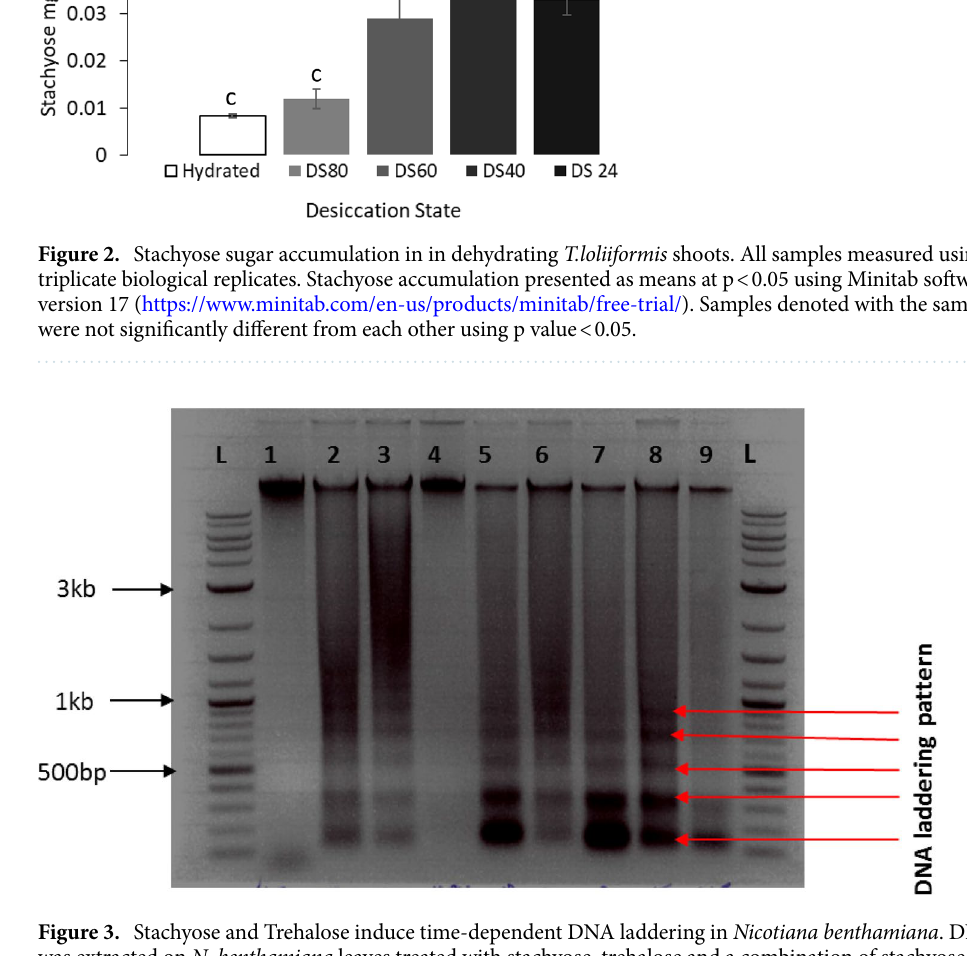
Figure 3. Stachyose and Trehalose induce time-dependent DNA laddering in Nicotiana benthamiana . DNA was extracted on N. benthamiana leaves treated with stachyose, trehalose and a combination of stachyose and trehalose sugars at 36 h and 48 h. 20 ng of the DNA was run on a 1% agarose gel. Potassium oxalate (KOX) treated sample was the positive control. L: 100 bp ladder; 1: untreated sample; 2/3: 20 mM KOX (36/48 h); 4/5: 5 mM Trehalose samples (36/48 h); 6/7: 3.2 mg/ml Stachyose treated samples (36/48 h); 8/9: 5 mM Trehalose + 3.2 mg/ml Stachyose (36/48